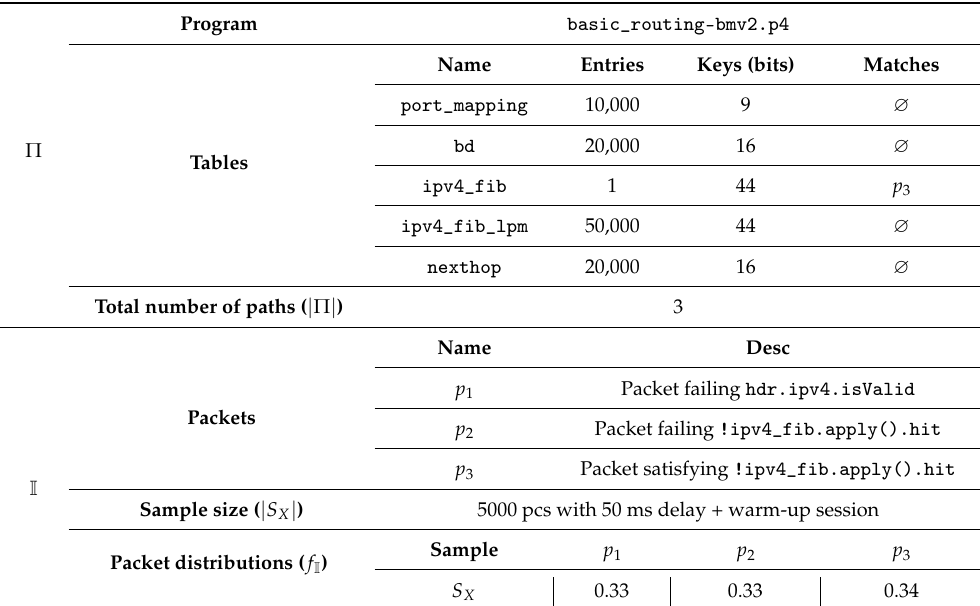
Table 4. ( Π , I ) configuration used for validation ( (cid:98) θ X ).